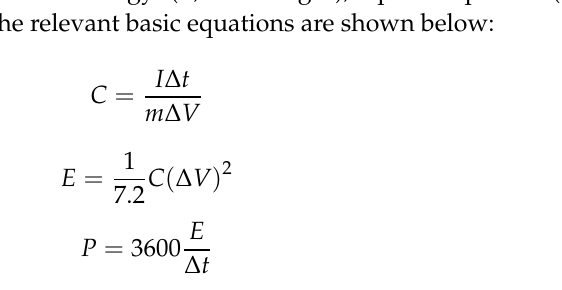
Table 1. The electrochemical capacitive performances of porous carbons derived from MOF-5 and other non-ZIF-based Zn-MOFs. S BET (m 2 P max (W E max (W h Samples C max (F g − 1 ) System Ref. g − 1 ) kg − 1 ) kg − 1 ) NPC 2872 312 - - 2E 27 NPC530 3040 158 - - 2E 28 NPC650 1521 222 - - 2E 28 NPC800 1141 151 - - 2E 28 NPC900 1647 148 - - 2E 28